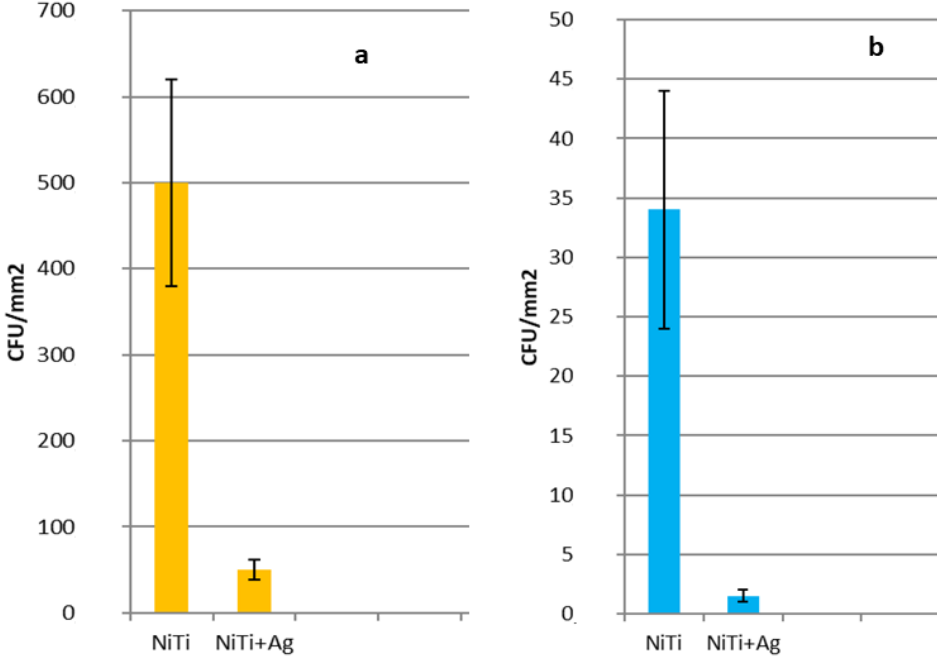
Figure 5. In vitro test (NiTi: nickel-titanium. NiTi + Ag: Nickel-Titanium with silver nanoparticles). Quantification of CFU/mm 2 for both NiTi archwires. ( a ) Streptococcus sanguinis. ( b ) Lactobacillus salivarius .